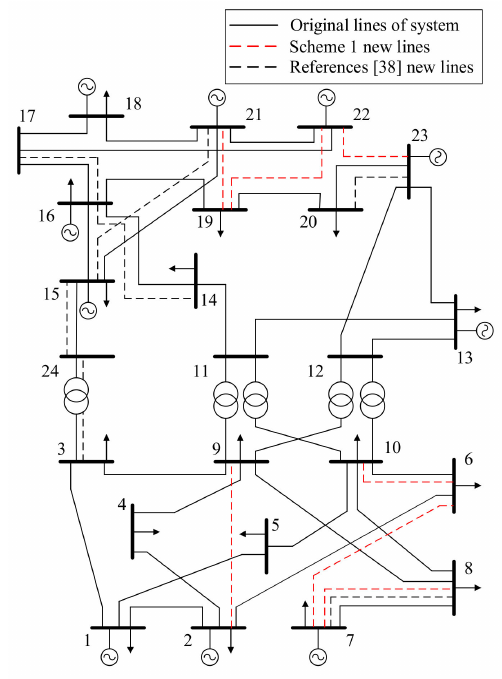
Figure 8. Comparison of planning